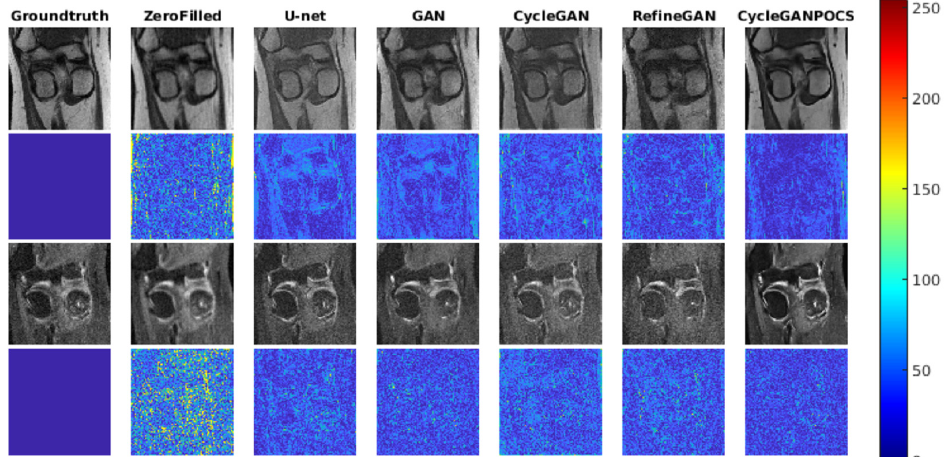
Figure 8. The fully sampled and undersampled knee images. The first and third rows are the knee images, and the second and fourth rows are the differences between the reconstructed image and the ground truth. The methods used for reconstructing the images are provided on top of each column. The undersampling rate was 20%, with a pseudo-random radial sampling trajectory. The color bar is set between [0, 255].